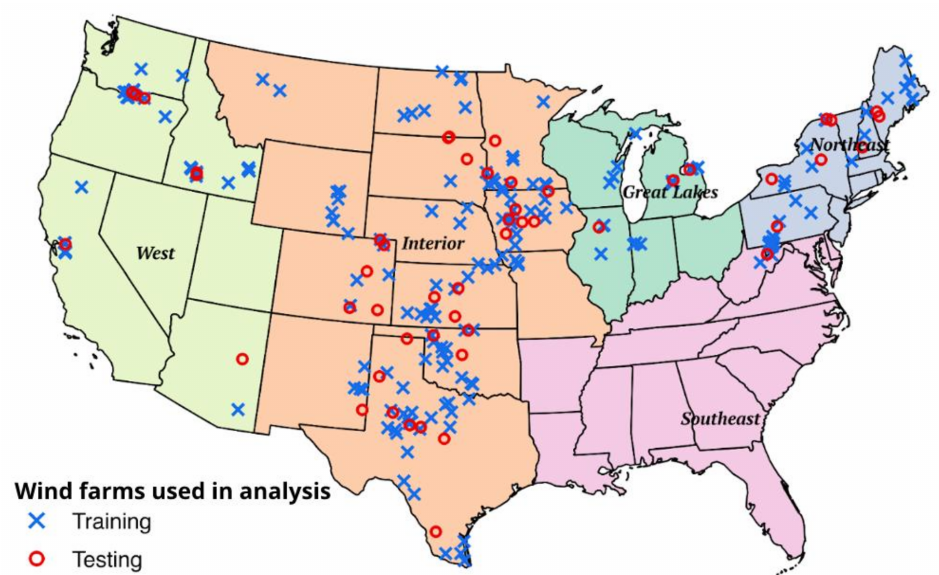
Figure 3. Spatial distribution of wind farm facilities used in model training and testing. Centroids of selected wind farms from the U.S. Wind Turbine Database [50] are displayed here in tandem with wind regions defined by the Department of Energy’s Office of Energy Efficiency and Renewable Energy (DOE EERE) [2]. As shown here, training and testing datasets were each designed to include observations of wind farms located in all regions of the country. This selection was done to minimize geographic biases that could otherwise limit the ability of the model to generalize across regions.